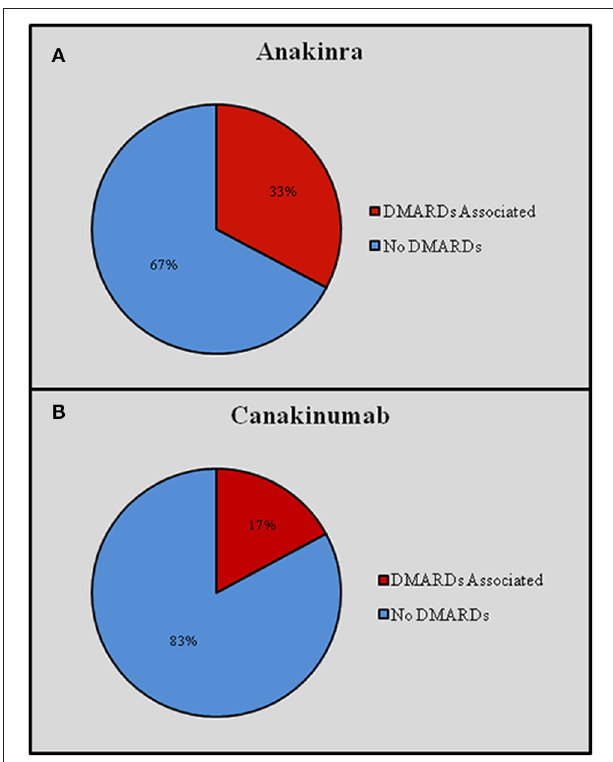
FIGURE 7 | Frequency of disease modifying antirheumatic drugs (DMARDs) concomitantly administered with Anakinra (A) and Canakinumab (B). DMARDs, disease modifying antirheumatic